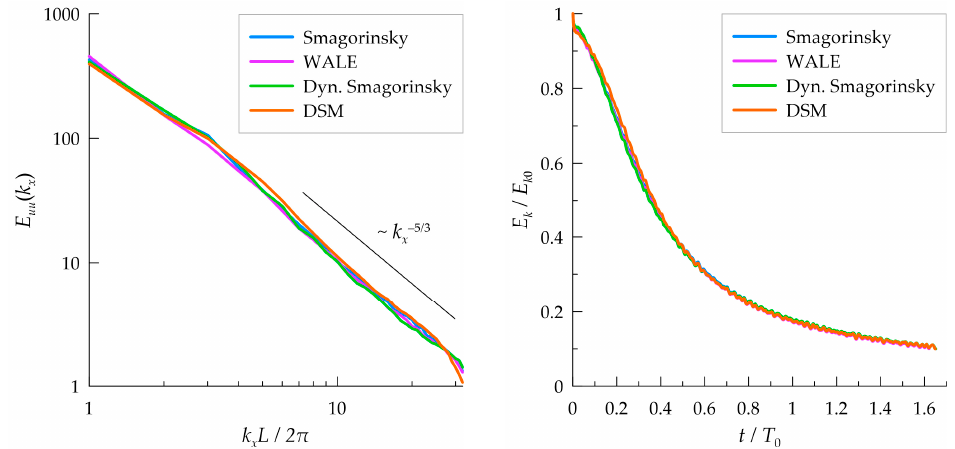
Figure 4. Longitudinal spectra at the end of the first stage ( left ) and resolved kinetic energy evolution during the first stage ( right ).